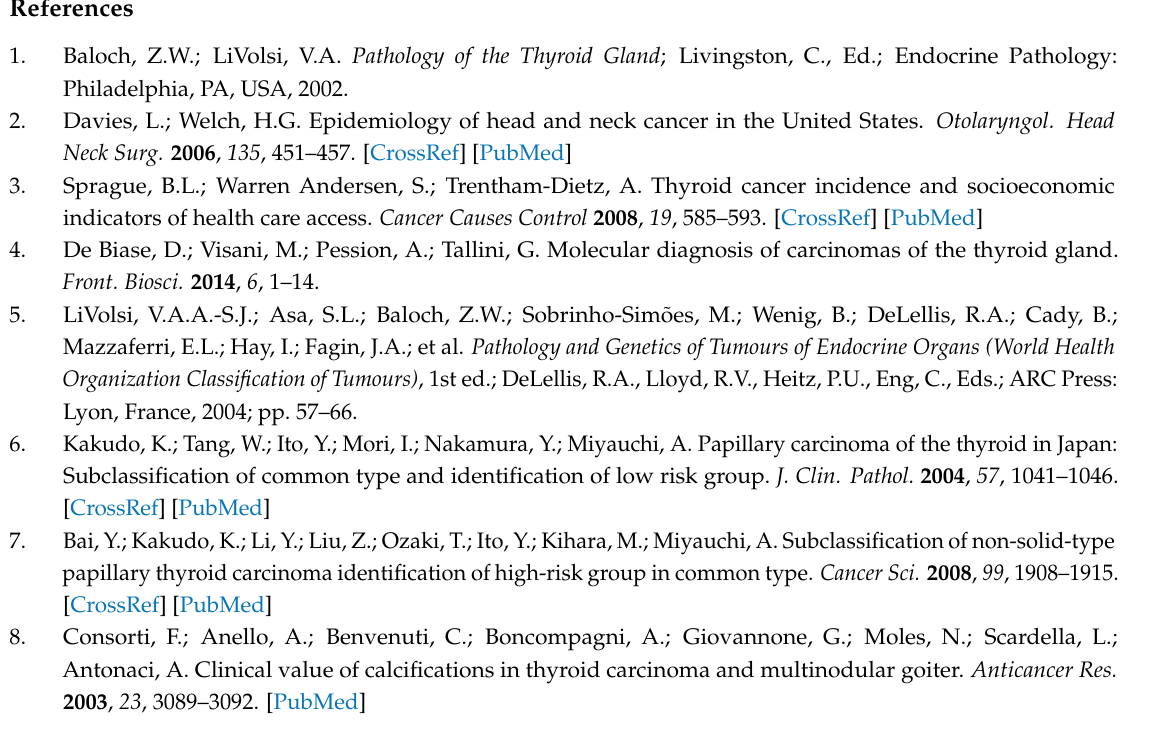
s1, Figure S1: Expression levels of OPNa, OPNb, OPNc and tOPN transcripts in cPTC samples, concerning presence or absence of PB. (A) OPNa (B) OPNb (C) OPNc and (D) tOPN mRNA expression levels were measured by real <me PCR in the cPTC samples. * p < 0.05. Results are from at least two independent assays with triplicates. Figure S2: Expression levels of three OPN splice variants in response to total OPN silencing; Table S1: Staining score of tOPN IHC in cPTC samples; Table S2: Correlation between tOPN protein expression and the clinicopathological characteristics in cPTC; Table S3: Correlation between the presence of PB and the clinicopathological characteristics in cPTC; Table S4: Predictive factors for lymph node metastases in